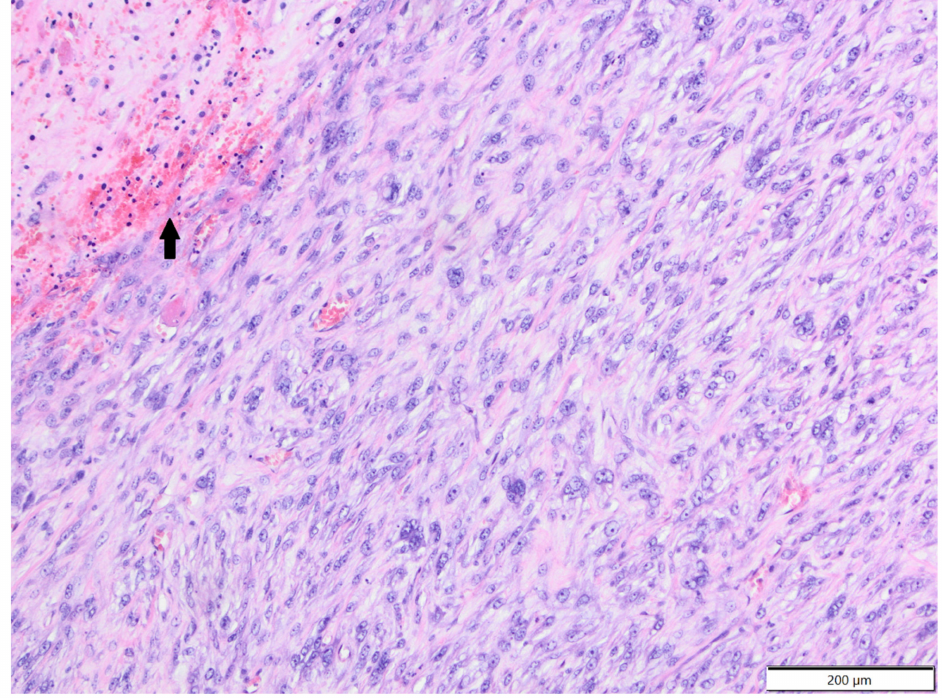
Figure 7. Fibrosarcoma, area unspecified, chinchilla. There are bundles of spindle to oval tumour cells and moderate amount of collagen fibres between them. Tumour cells undergo focal necrosis (arrow).